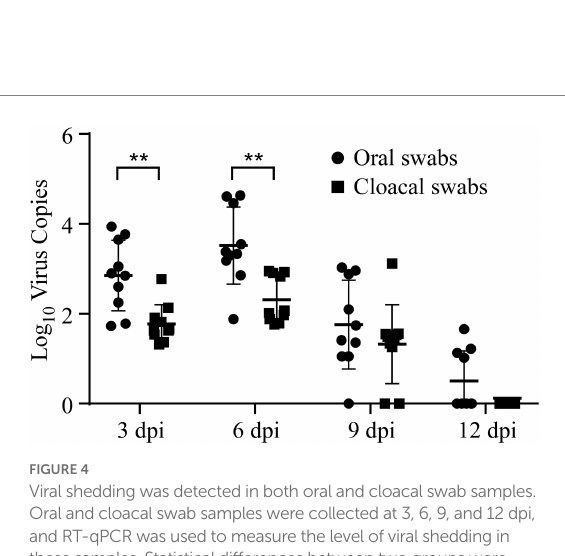
FIGURE 5 Decreased egg production was observed in the challenge group. The number of eggs in each group was counted from 21 to 25 weeks. Statistical differences between two groups were assessed by the Student’s t -test Statistical significance was defined as follows: * p < 0.05, *** p < 0.001.